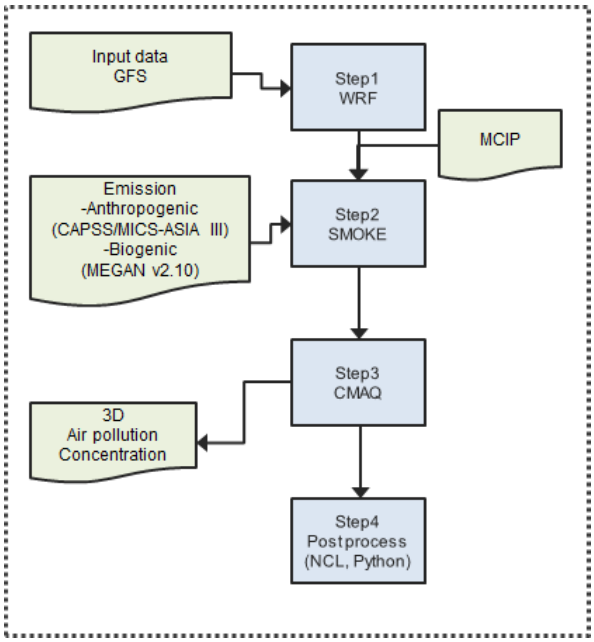
Figure 4. Operating procedure of CMAQ model.